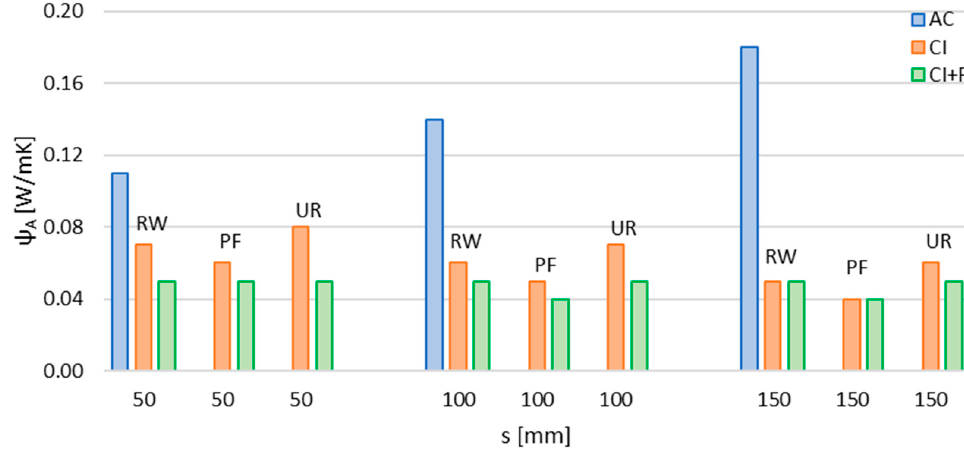
Figure 2. Linear thermal transmittance Ψ ie of edge thermal bridge without pillar.